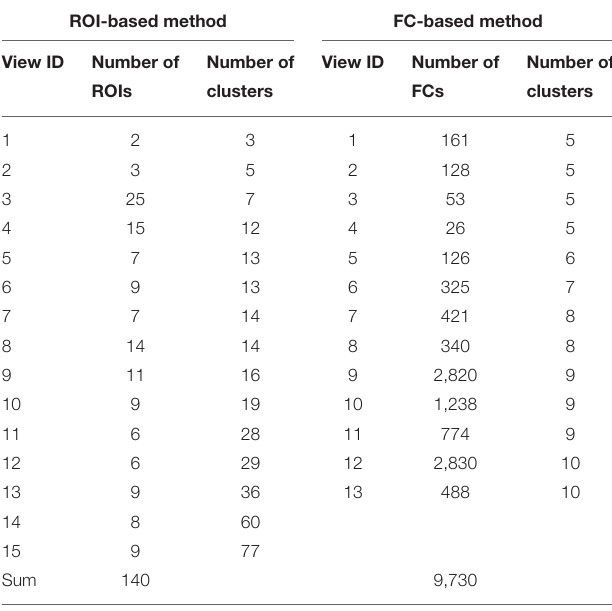
TABLE 3 | Summary of the multiple clustering